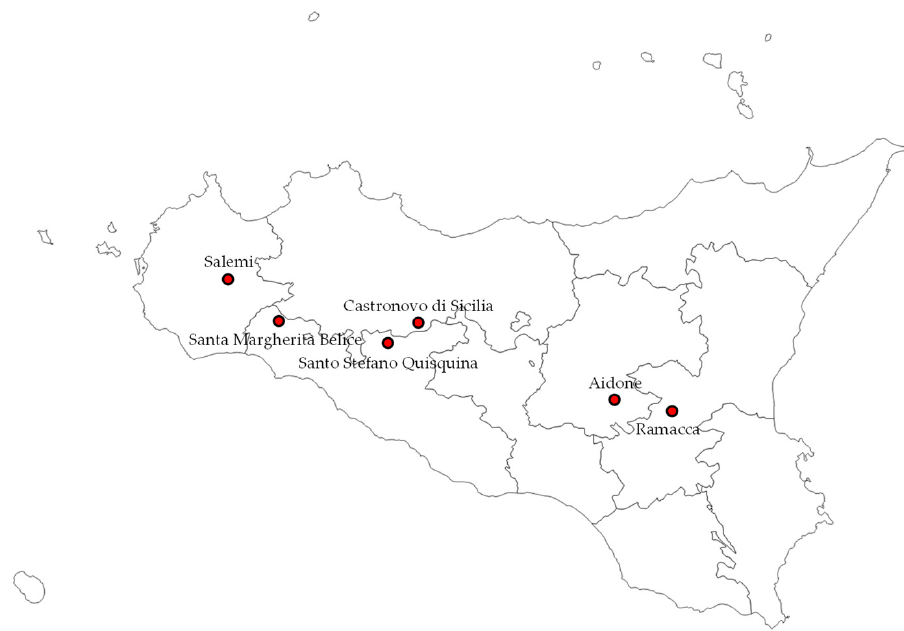
Figure 7. Location of the dairy factories producing PDO Pecorino Siciliano cheese.